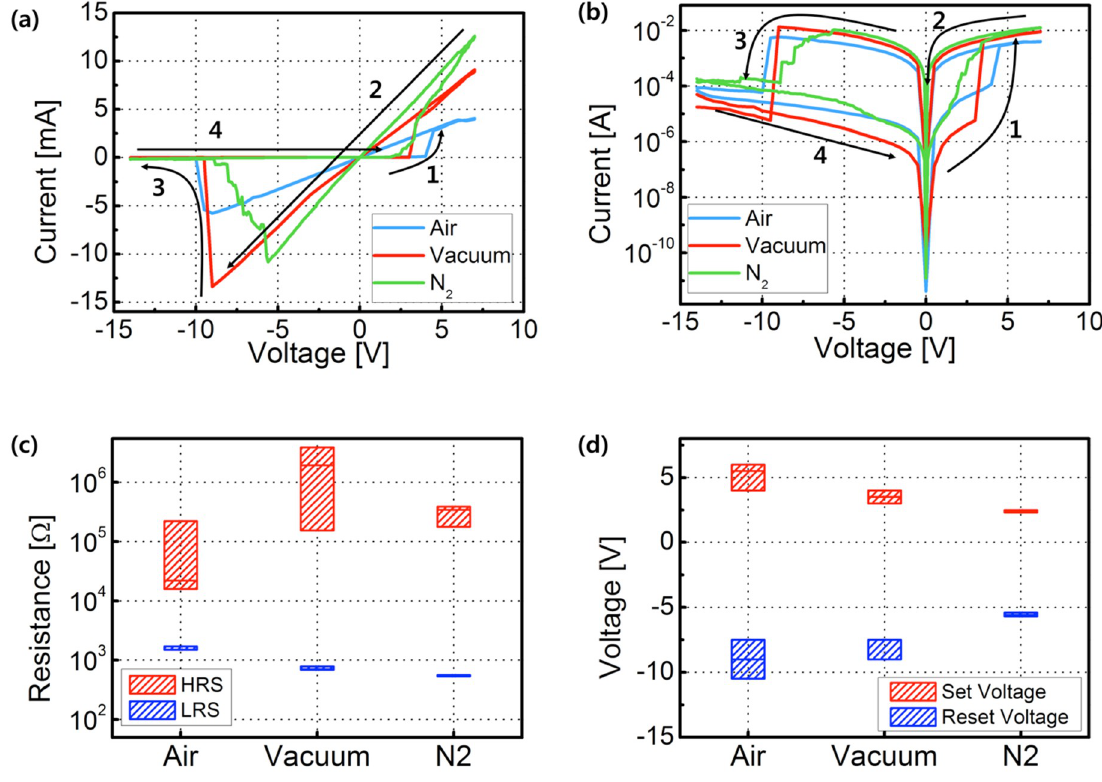
Figure 4. Representative I–V curves obtained from ITO / ZrO 2 / Ag RRAM devices. The arrows and numbers indicate the voltage sweep directions. ( a ) Linear scale and ( b ) log scale, while ( c ) HRS / LRS values and ( d ) SET / RESET voltages.